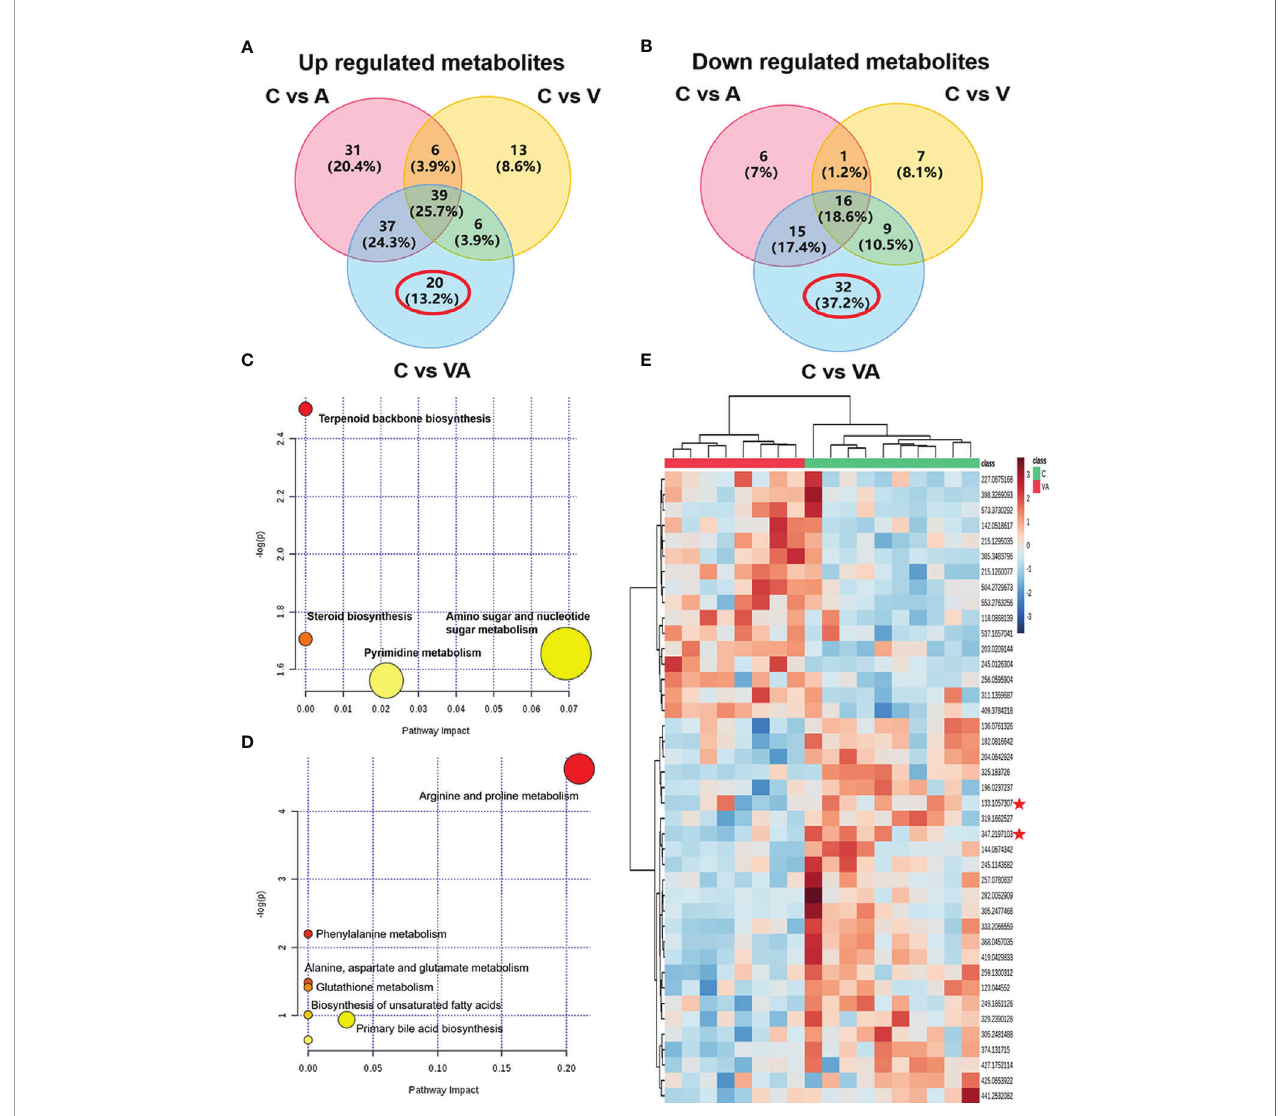
FIGURE 5 | Ornithine is a therapeutic target of VA treatment in MM mice. (A) Venn diagram displaying the 20 upregulated distinct metabolites in the serum of Group VA. (B) Venn diagram displaying the 32 downregulated distinct metabolites in the serum of Group VA. (C) Summary of joint pathway analysis in group VA with MetaboAnalyst 5.0. (D) Summary of joint pathway analysis in group VA with MetaboAnalyst 5.0. (E) Heatmap showing arginine and ornithine were downregulated metabolites in group